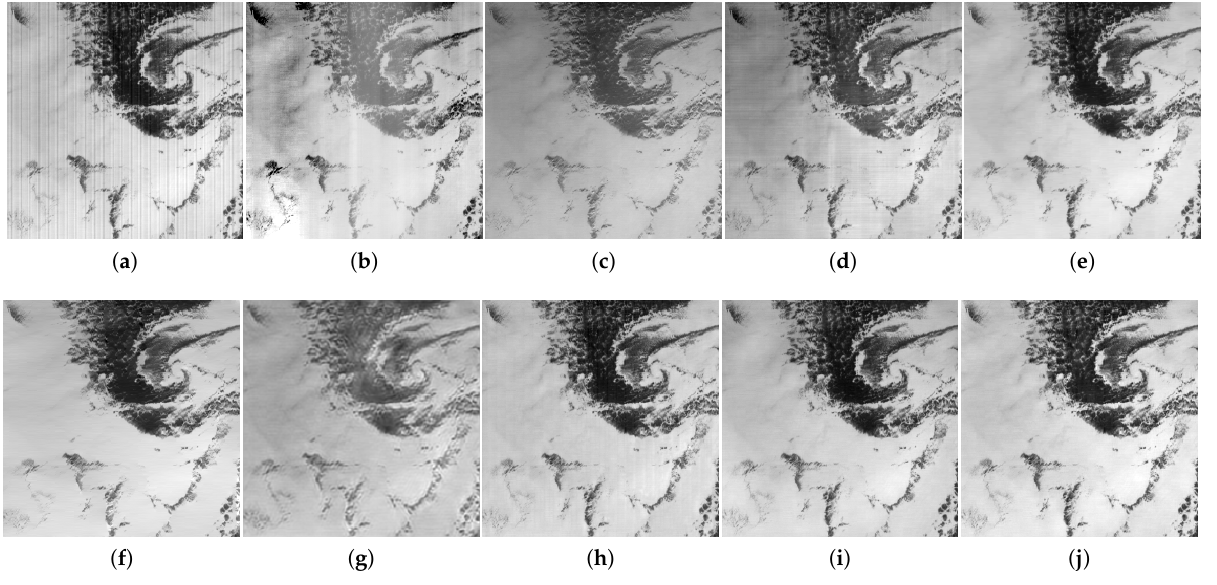
Figure 12. Corrected Terra MODIS images for band 9. ( a ) Terra MODIS image. Images corrected